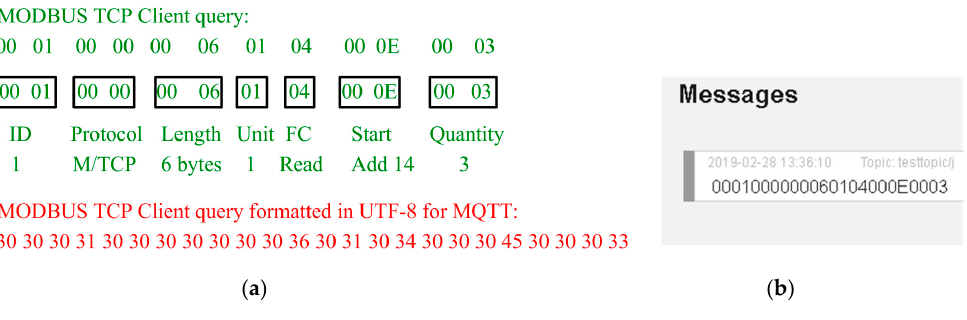
Figure 13. ( a ) MODBUS message formatted via UTF-8 in the MQTT payload to solve the interoperability problem in the second scenario; ( b ) message as it appeared on hivemq.com consumer. Table 3. UTF-8 encoding